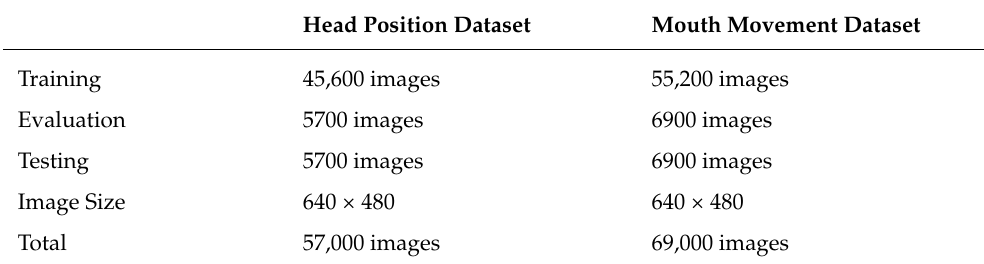
Table 6. Image count for the transfer learning